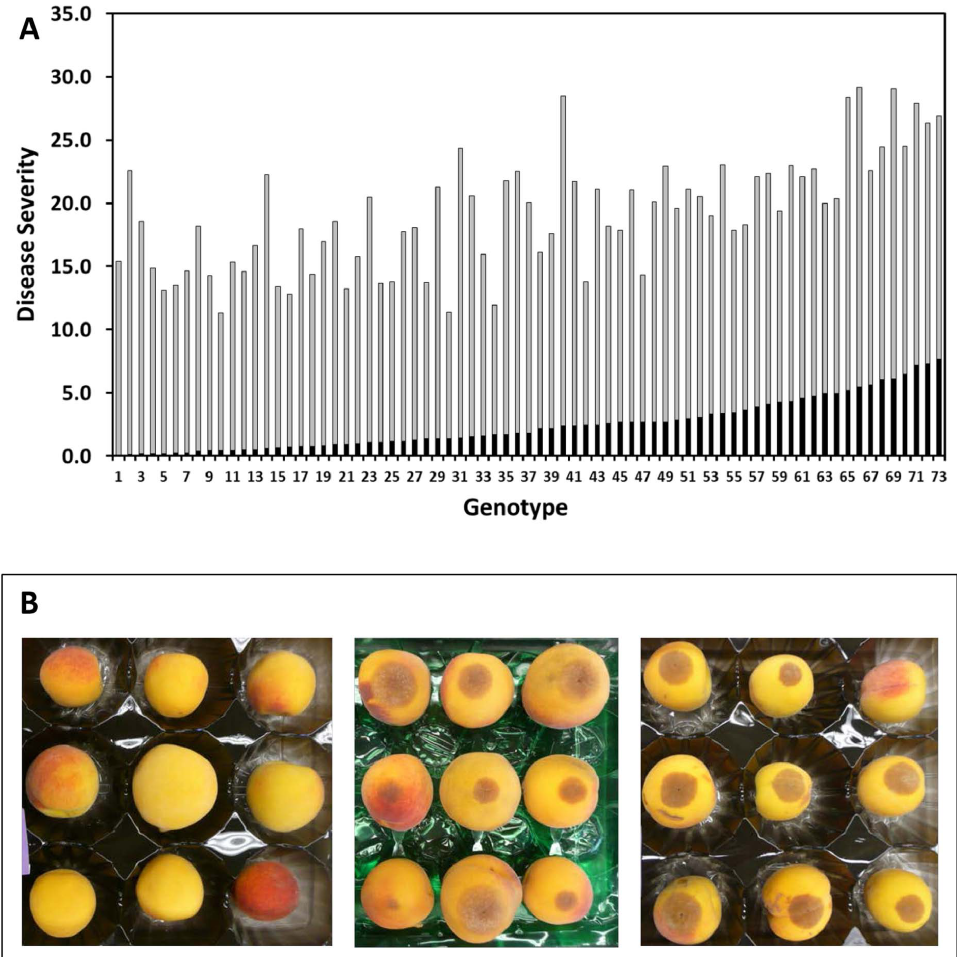
Figure 1. Disease analysis. Average disease severity for each of 73 genotypes within the PopDF population over three seasons (2007–2009) in order of increasing values for non-wounded fruit (black column) and the corresponding disease severity in wounded fruit for that genotype (gray column) (A). Representative fruit disease reactions of highly resistant (genotype 01,9–38; left panel) and highly susceptible (genotype 01,9–230; middle panel) peach genotypes in PopDF, 72 hours after inoculation with Monilinia fructicola . The average disease severity values corresponding to these sets of fruit are 0.0 (left) and 13.8 (middle). Right panel, disease reaction of wounded fruit of genotype 01,9–38. The average disease severity value corresponding to this set of fruit is 13.7